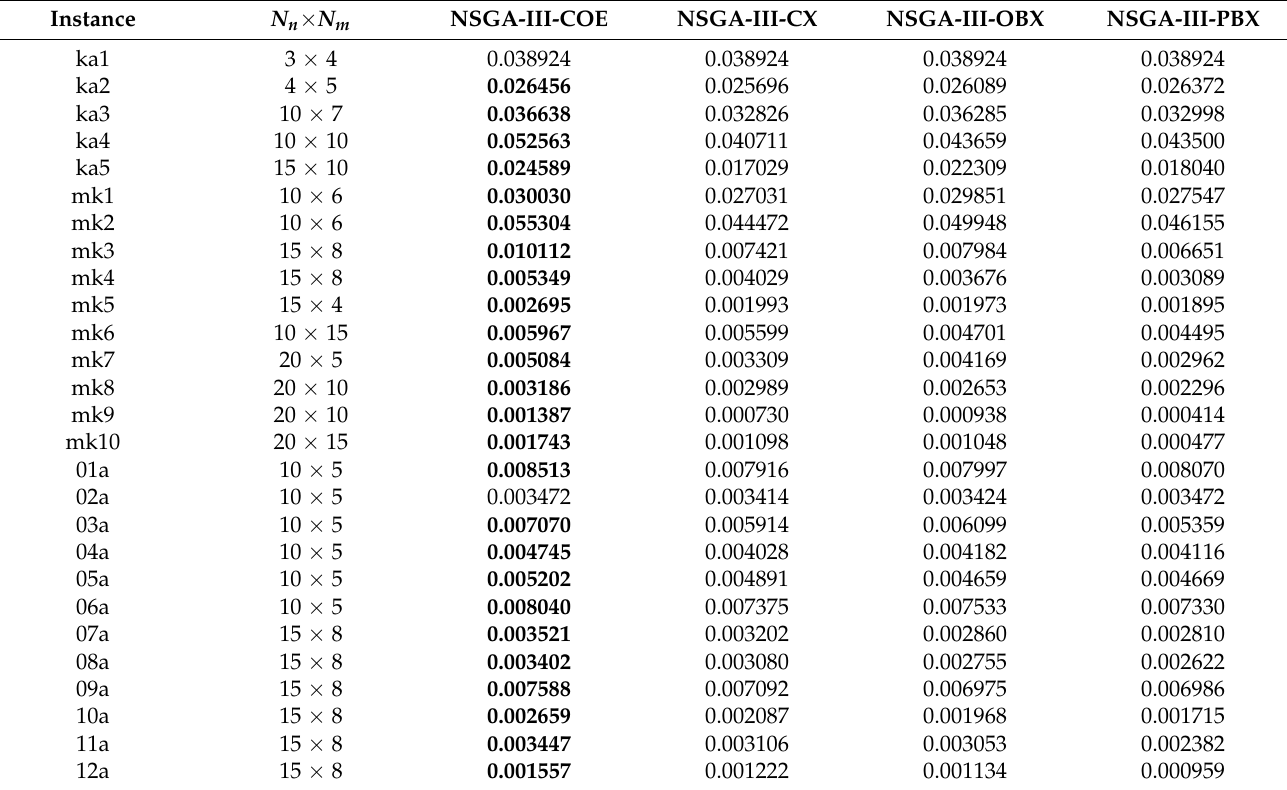
Table 5. Performance evaluation of NSGA-III-COE, NSGA-III-CX (cycle crossover), NSGA-III-OBX (order-based crossover), and NSGA-III-PBX (partially mapped crossover); the average HVs of 27 problem cases running independently 30 times.